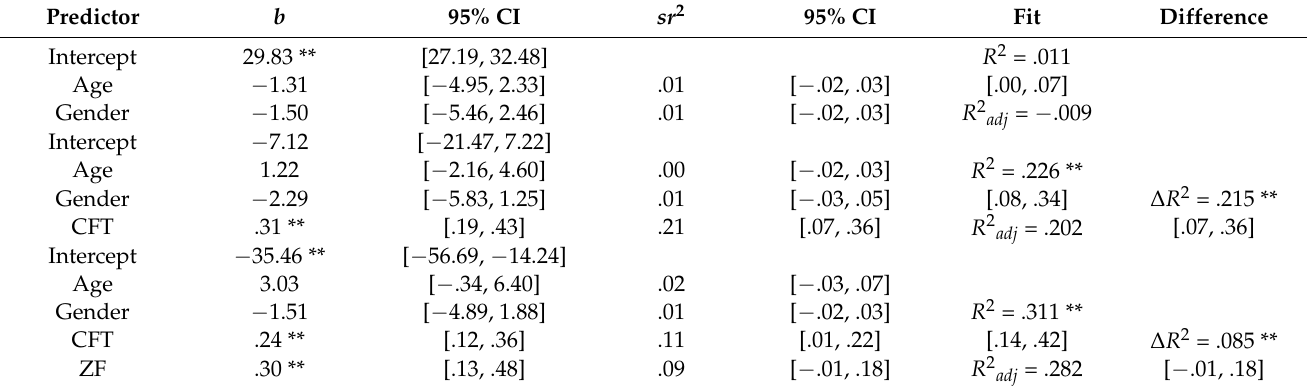
Table 4. Regressing mathematical abilities onto fluid intelligence and numerical processing